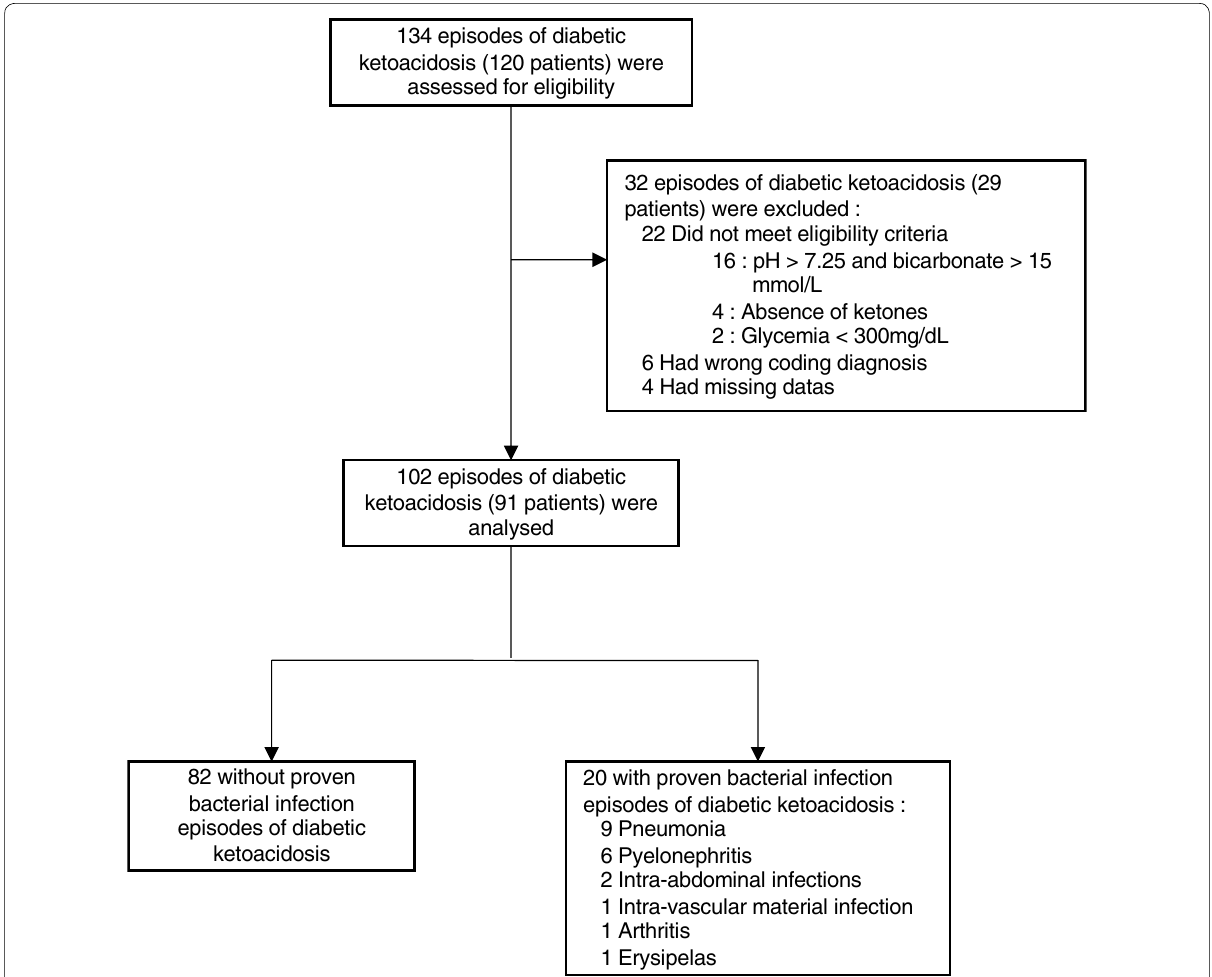
Fig. 1 Flowchart of study population and sample size. Shown is the recruitment of the